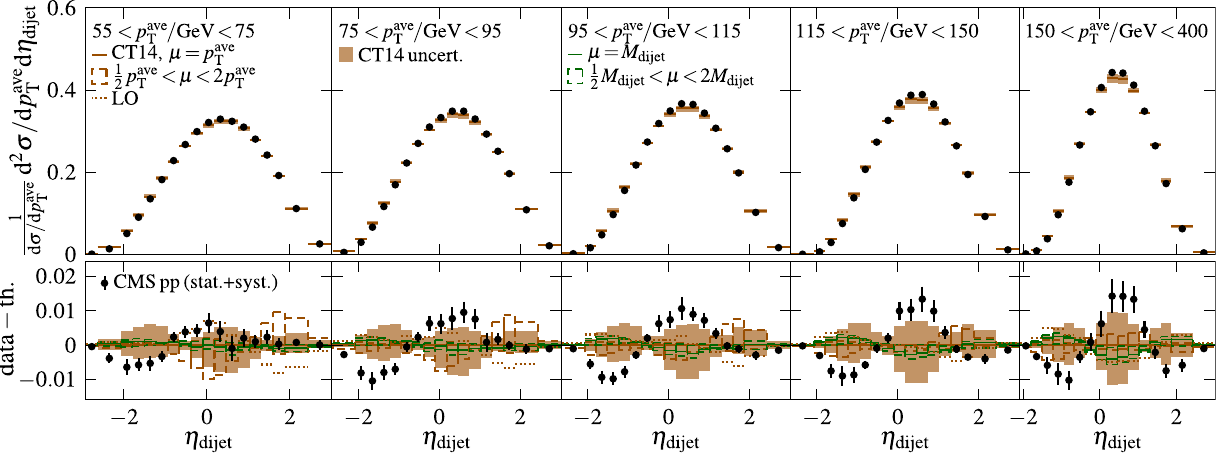
Fig. 2 Upper panels: distributions of dijets in 5.02 TeV proton–proton collisions against η dijet and normalized to unity in each bin of p ave imposed kinematic cuts are discussed in text. Black markers show the data from the CMS measurement [4] with vertical bars showing the sta- tisticaland systematicaluncertainties added in quadrature. Solid orange lines represent the results from the NLO pQCD calculation using the central set of the CT14 NLO PDFs [5] with μ = p ave